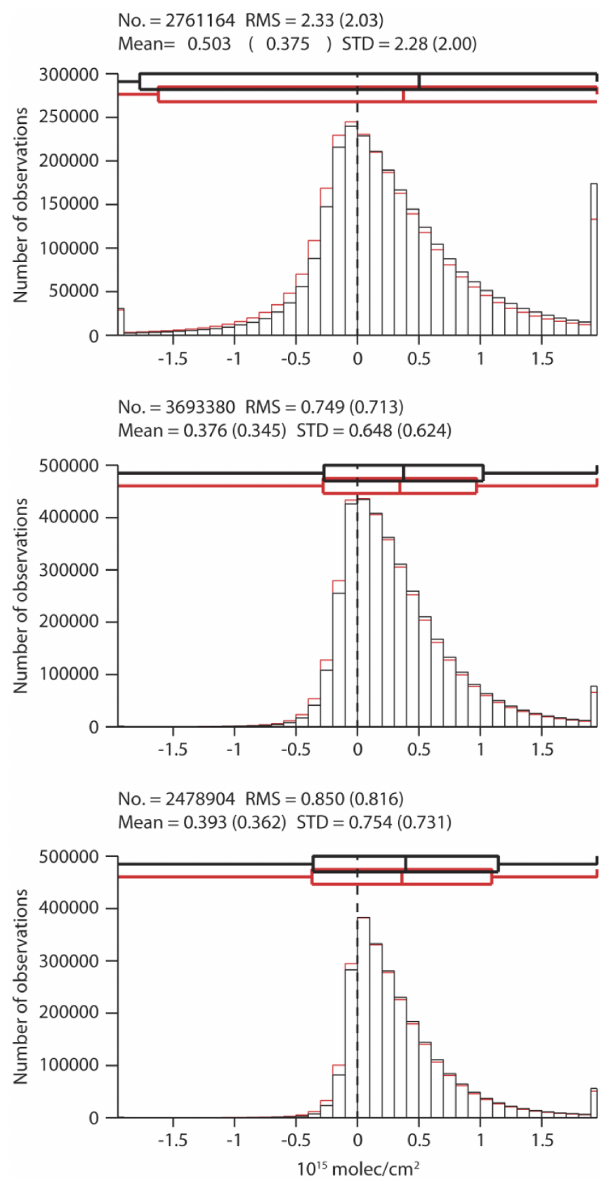
Figure 17. Histograms of OMI TRCNO2 analysis departures for CIFS-AN (red) and CIFS-CTRL (black) for 2008 averaged over the NH (90–20 ◦ N, top), the tropics (20 ◦ N–20 ◦ S, middle) and the SH (20–90 ◦ S, bottom) for all good data in 10 15 moleculescm − 2 . Also shown above the panels are the number of observations that make up the average, as well as the mean, RMS and SD of the departures with values for REAN in